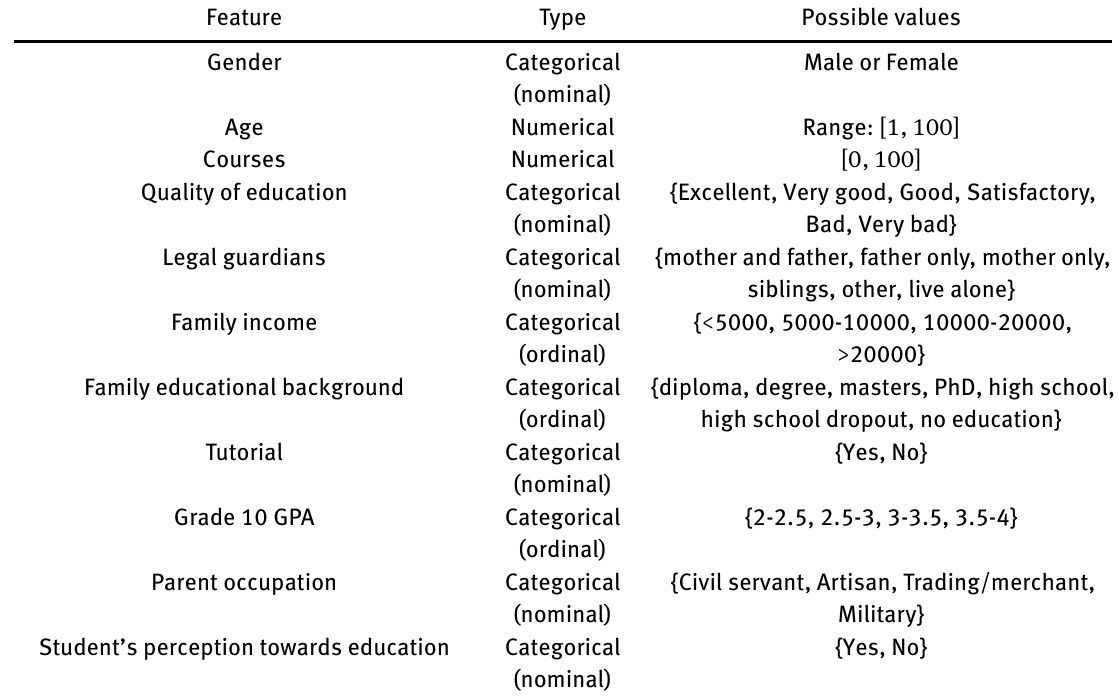
Table 1: Dataset features with possible